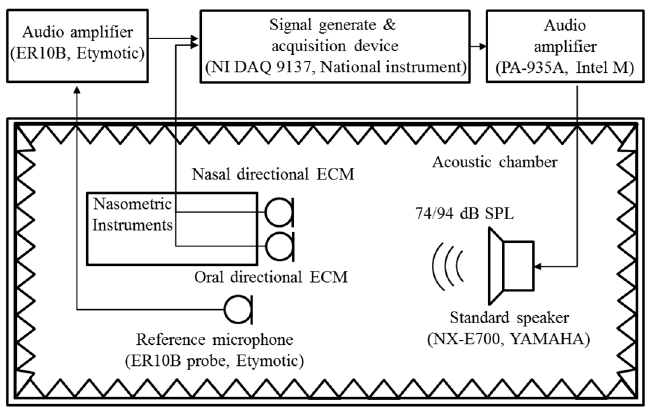
Figure 2. Experimental schematic using the structure of conventional nasometric instruments.